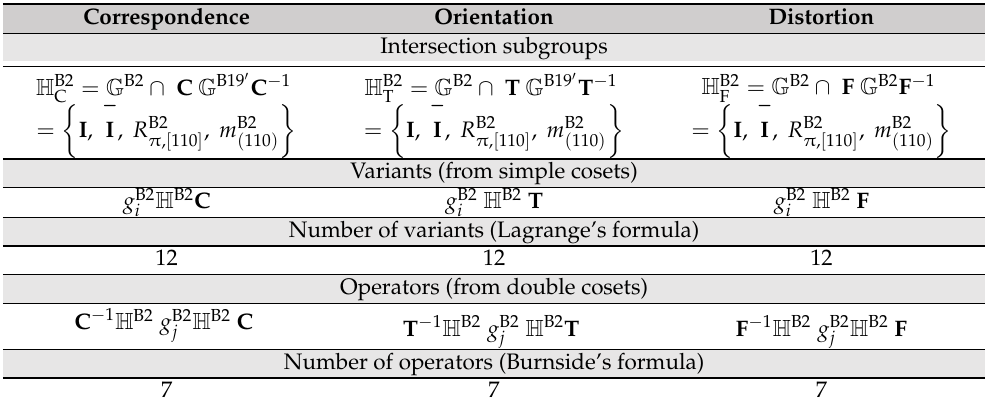
= H B2 = H B2 and is just noted as H B2 C T F